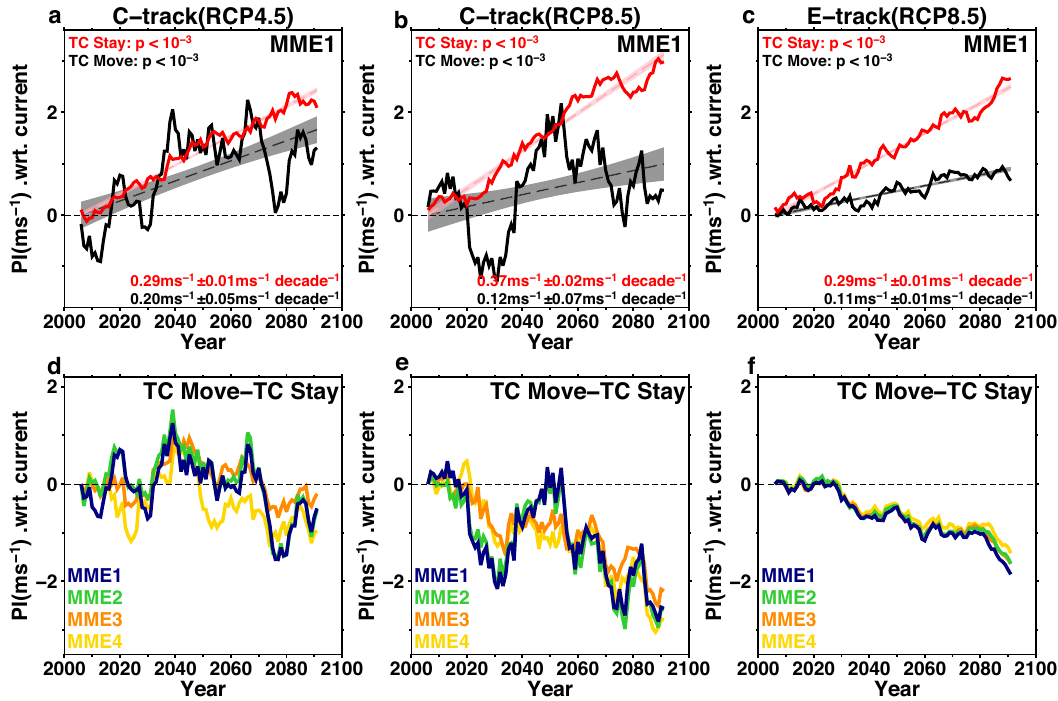
Fig. 4 Time series of Averaged PI. Top ( a , b , c ): Averaged PI time series of the 3 track groups, with trends and p-values, based on MME1. 95% con fi dence trend bounds are shaded. The regression lines are aligned at the zero point for trend comparison. Bottom ( d , e , f ): The difference between TC_Move and TC_Stay, i.e., poleward migration ’ s negative effect, for the 3 track groups. All 4 MMEs are